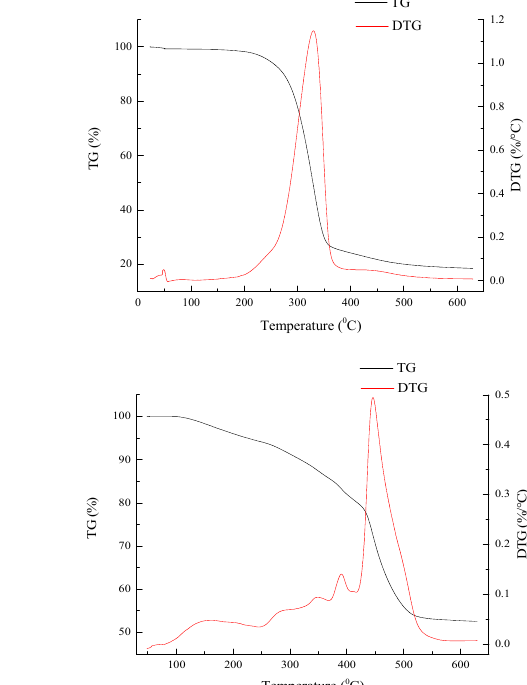
Figure 11. The results of thermogravimetric analysis of the BC original sample and composite: ( a ) BC original sample; ( b ) composite.